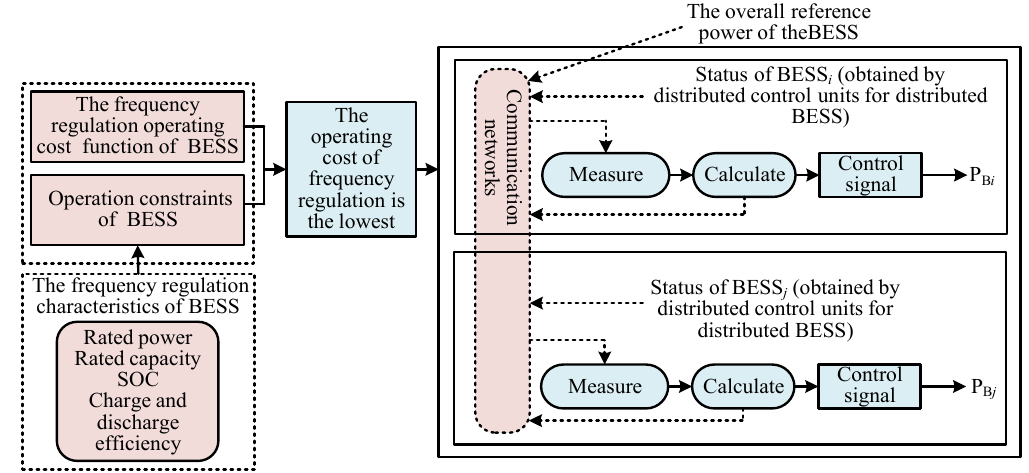
Figure 6. Distributed coordinated control strategy at the BESS station level.